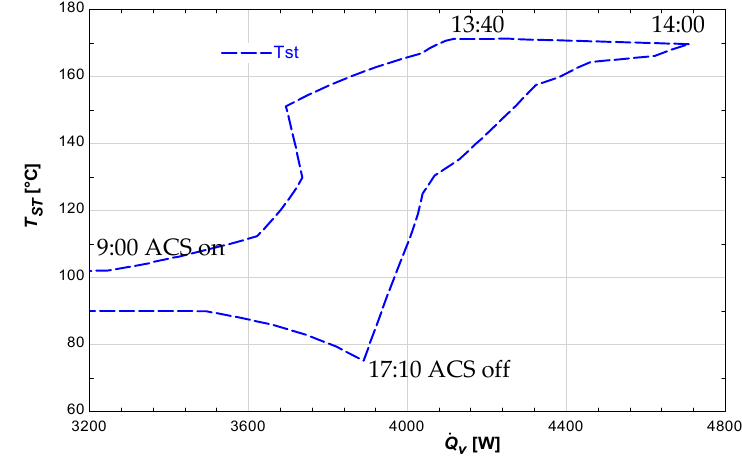
Figure 9. Cooling load influence on the storage tank fluid temperature along the day; case study 10 m PTC, 0.16 m 3 water storage tank.